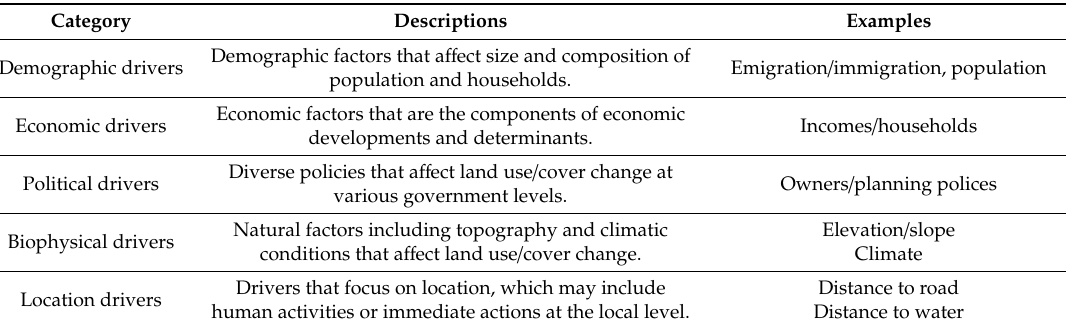
Table 1. Category, descriptions, and examples of the underlying driving